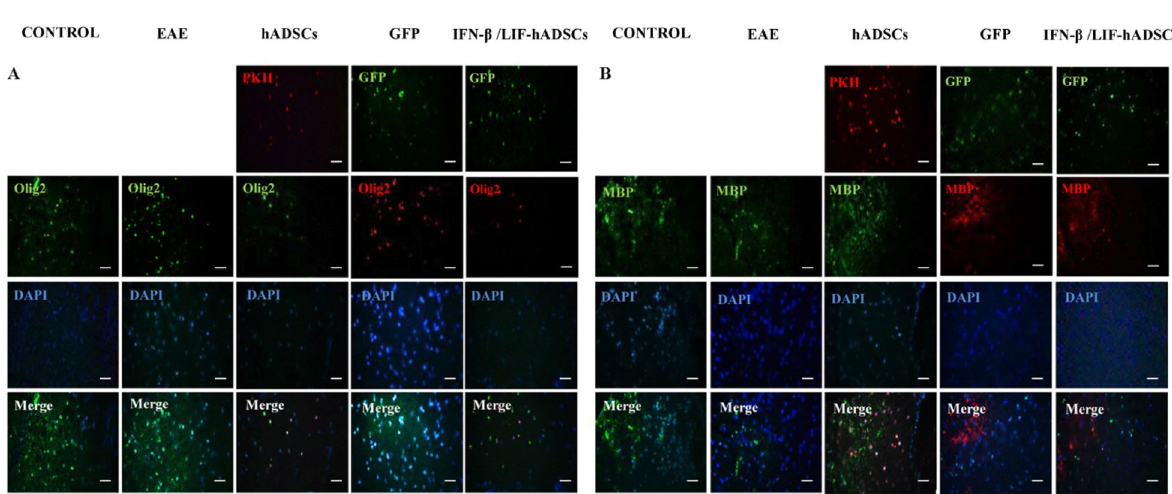
Figure 6. Fluoromicrographs of oligodendrocyte markers in hADCs. Immunofluorescence staining of selected spinal cord slides of five groups with antibodies (A, Olig2, and B,